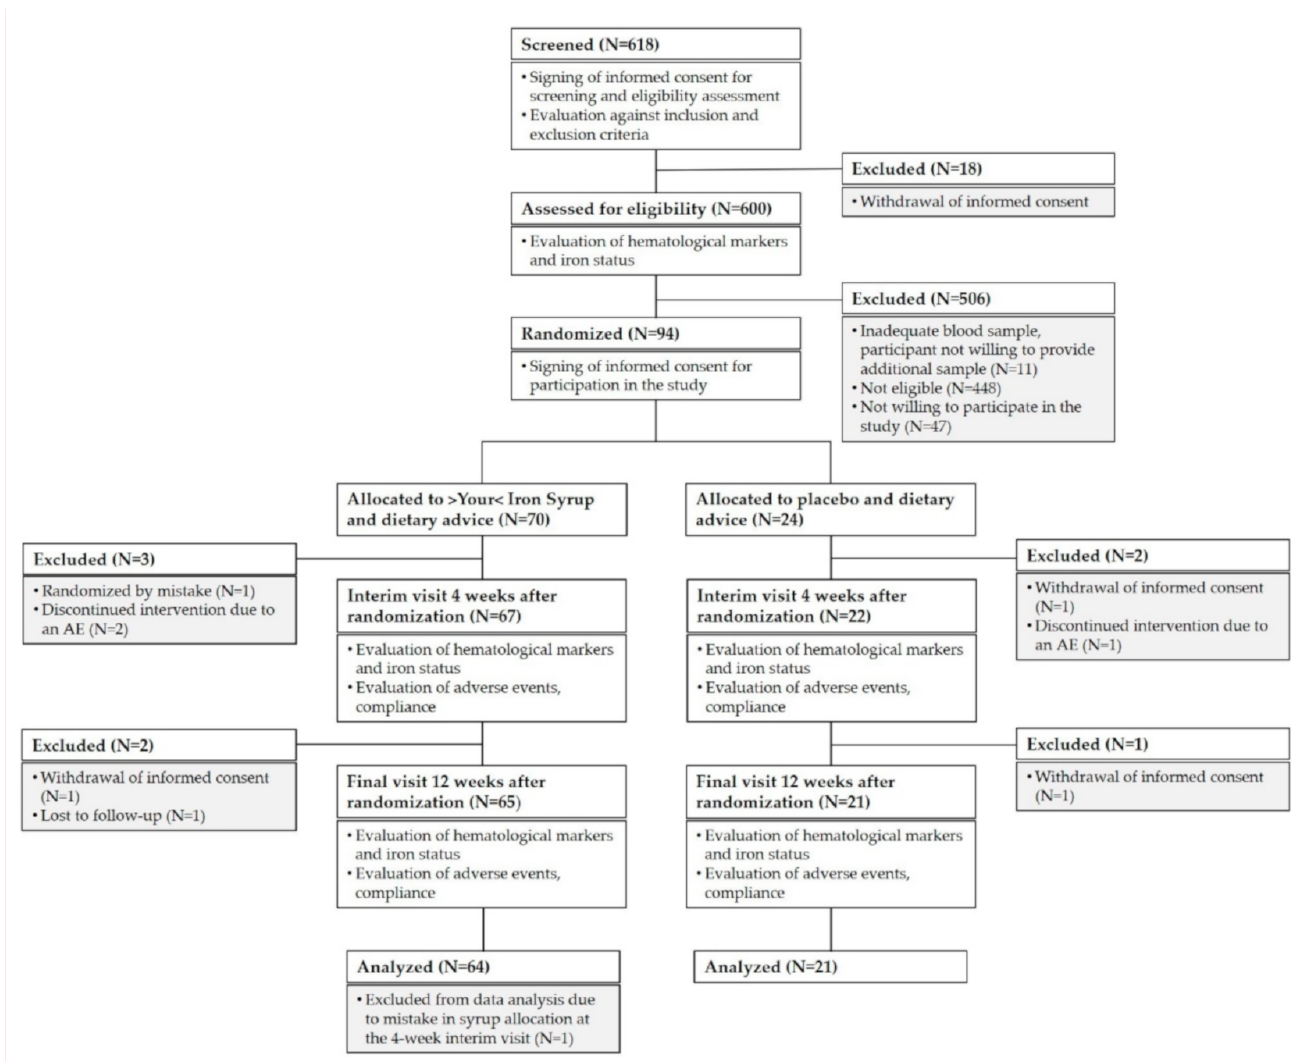
Figure 1. Flow diagram of the participant’s progress through the